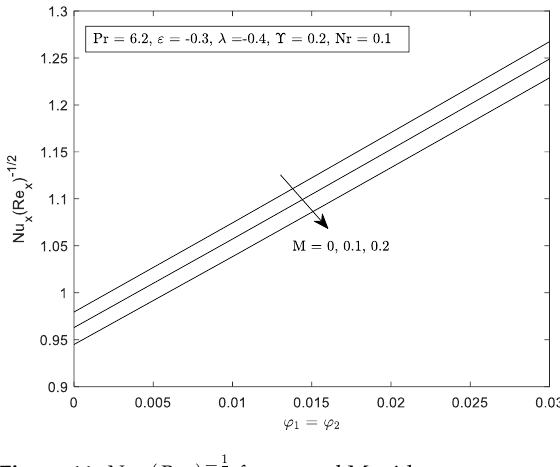
Figure 11. Nu x ( Re x ) − Figure 11. 𝑁𝑢 𝒙 (𝑅𝑒 𝒙 ) − Figure 11. 𝑁𝑢 𝒙 (𝑅𝑒 𝒙 ) −